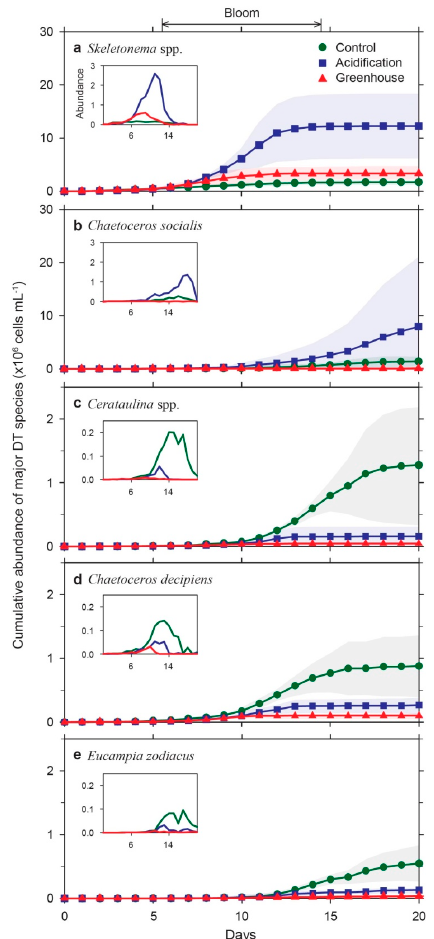
Figure 5. Changes in the cumulative cell abundance of major diatom species during the study period: ( a ) Skeletonema spp.; ( b ) Chaetoceros socialis ; ( c ) Cerataulina spp.; ( d ) Chaetoceros decipiens ; and ( e ) Eucampia zodiacus . (Insets) Changes in the cell abundance during the same period. The symbols and the color shading represent the same as shown in Figure 2.